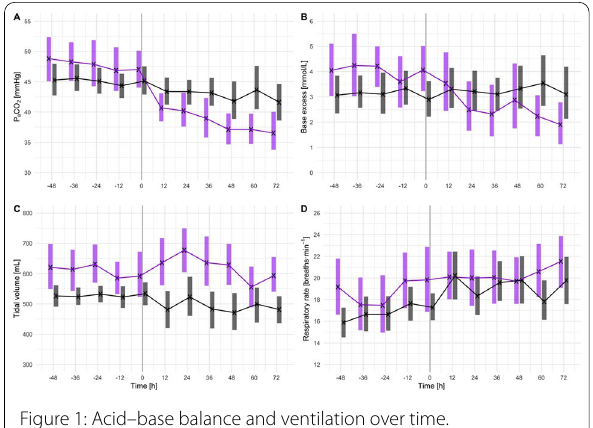
Figure 1: Acid–base balance and ventilation over